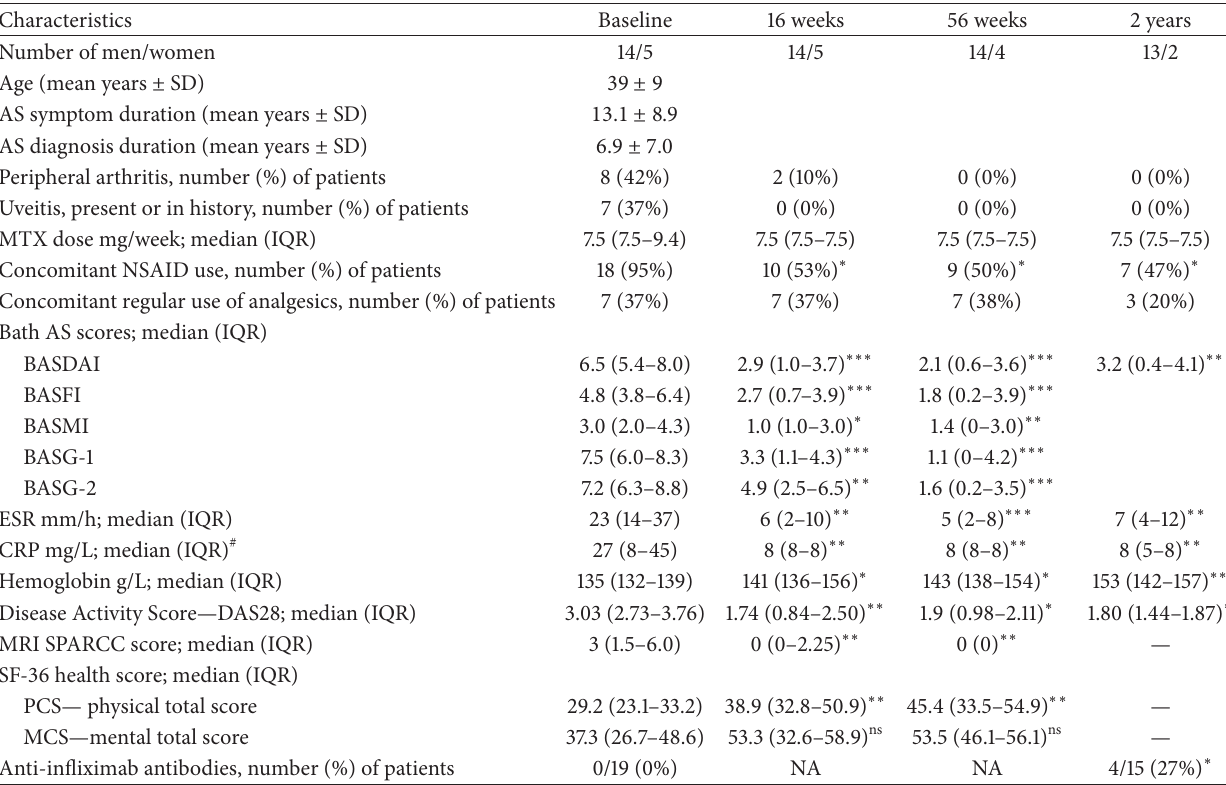
Table 1: Clinical and laboratory characteristics of patients at baseline and following treatment with infliximab 5 mg/kg every 6 weeks (time points at 16 weeks and 56 weeks) and after continuing infliximab treatment 3mg/kg every 8 weeks (time point at 2